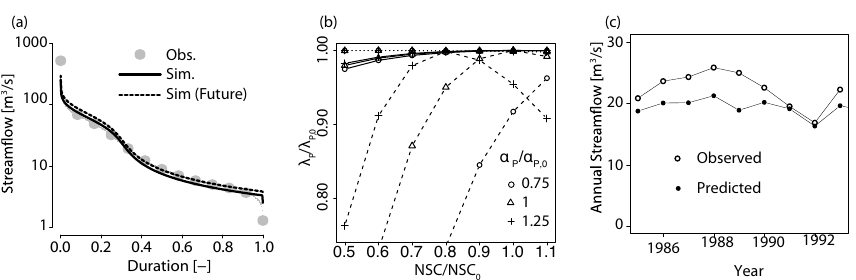
Figure 3. Sensitivity of models to changes in the precipitation regime. (a) Empirical and simulated flow duration curves at Chepe Kohla. The simulated FDC obtained from the stochastic rainfall generator and the bucket watershed model (solid) reproduce the empirical FDC constructed from the observed streamflow well (grey dots). Rainfall changes expected in Nepal ( α P /α P , 0 = 1 . 2, λ P /λ P , 0 = 0 . 98) do not have a substantial influence on the simulated flow distribution (dashed). α P and λ P designate the mean depth and frequency of wet-season rainfall, respectively. (b) Sensitivities to relative changes in rainfall frequency and intensity over the Chepe Kohla catchment. The performance of the process-based model is not affected by rainfall changes (dotted). The sensitivity of the statistical model depends on its ability to predict changes in mean flow from annual rainfall. The model is highly sensitive to rain changes if average streamflow cannot be predicted (dashed), and is robust to moderate changes if average flow is perfectly predicted (solid). (c) The linear regression of the statistical model underestimates annual flows at the Chepe Kohla when using a cross-sectional sample (25 gauges) to estimate the local relation between average rainfall and average